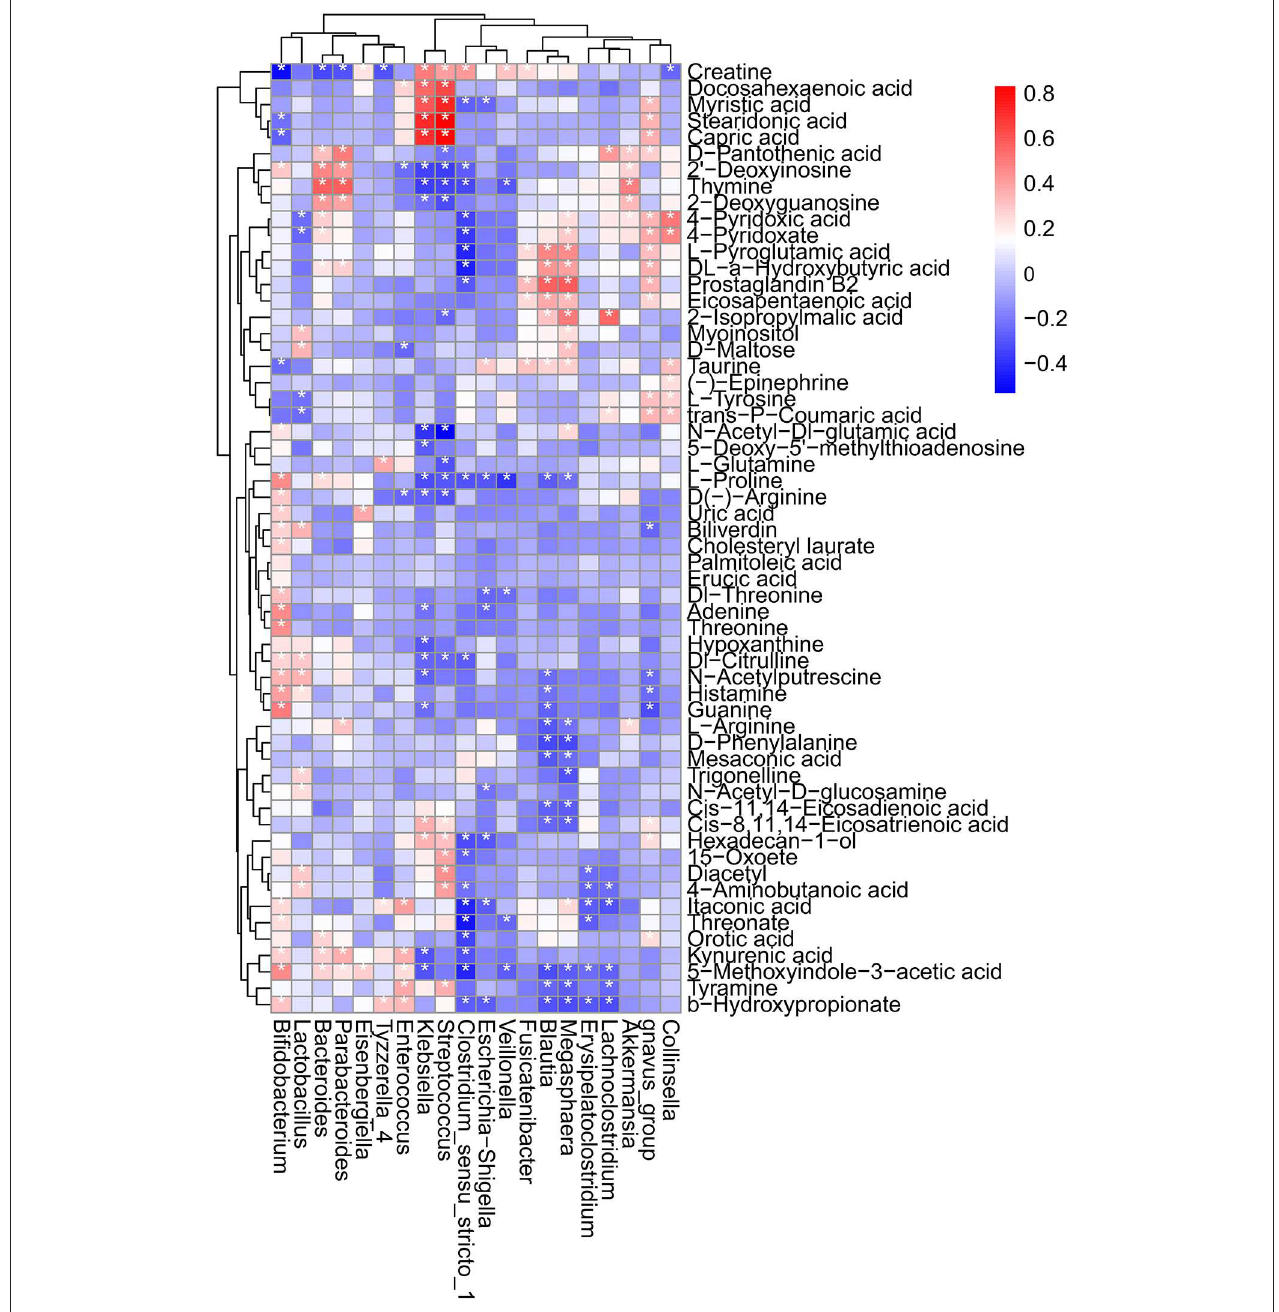
FIGURE 7 | Heatmap diagram representing the correlation between the top 20 microbiota and specific metabolites of the four feeding methods. * p <